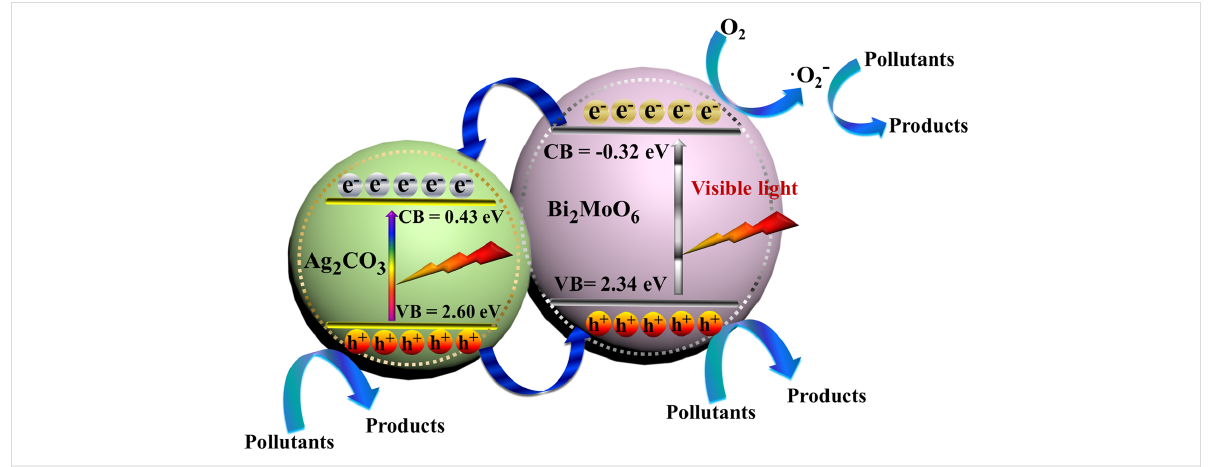
Figure 10: Proposed photocatalytic degradation mechanism of Ag 2 CO 3 /Bi 2 MoO 6 .